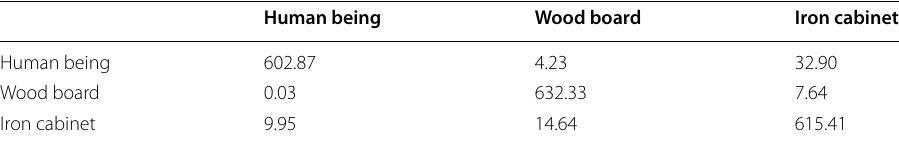
Table 4 Confusion matrix of the DFA-KNN approach Human being Wood board Iron cabinet Human being 602.87